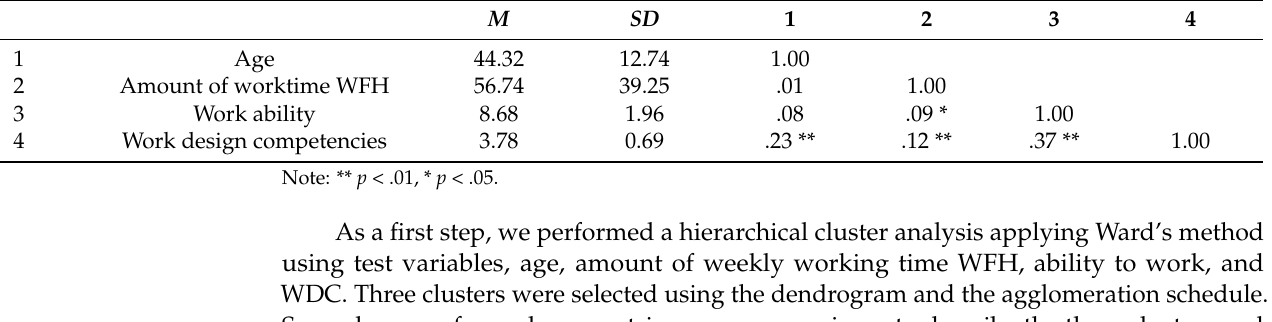
Table 1. Descriptive statistics and bivariate correlations of test variables ( N = 735). M